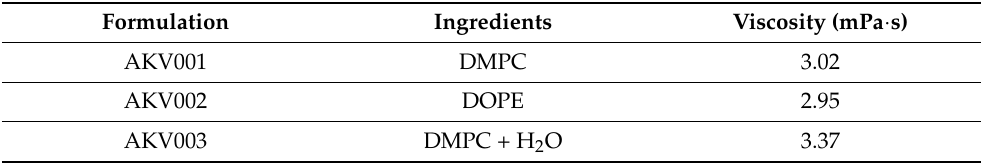
Table 2. Dynamic viscosities of AKVANO